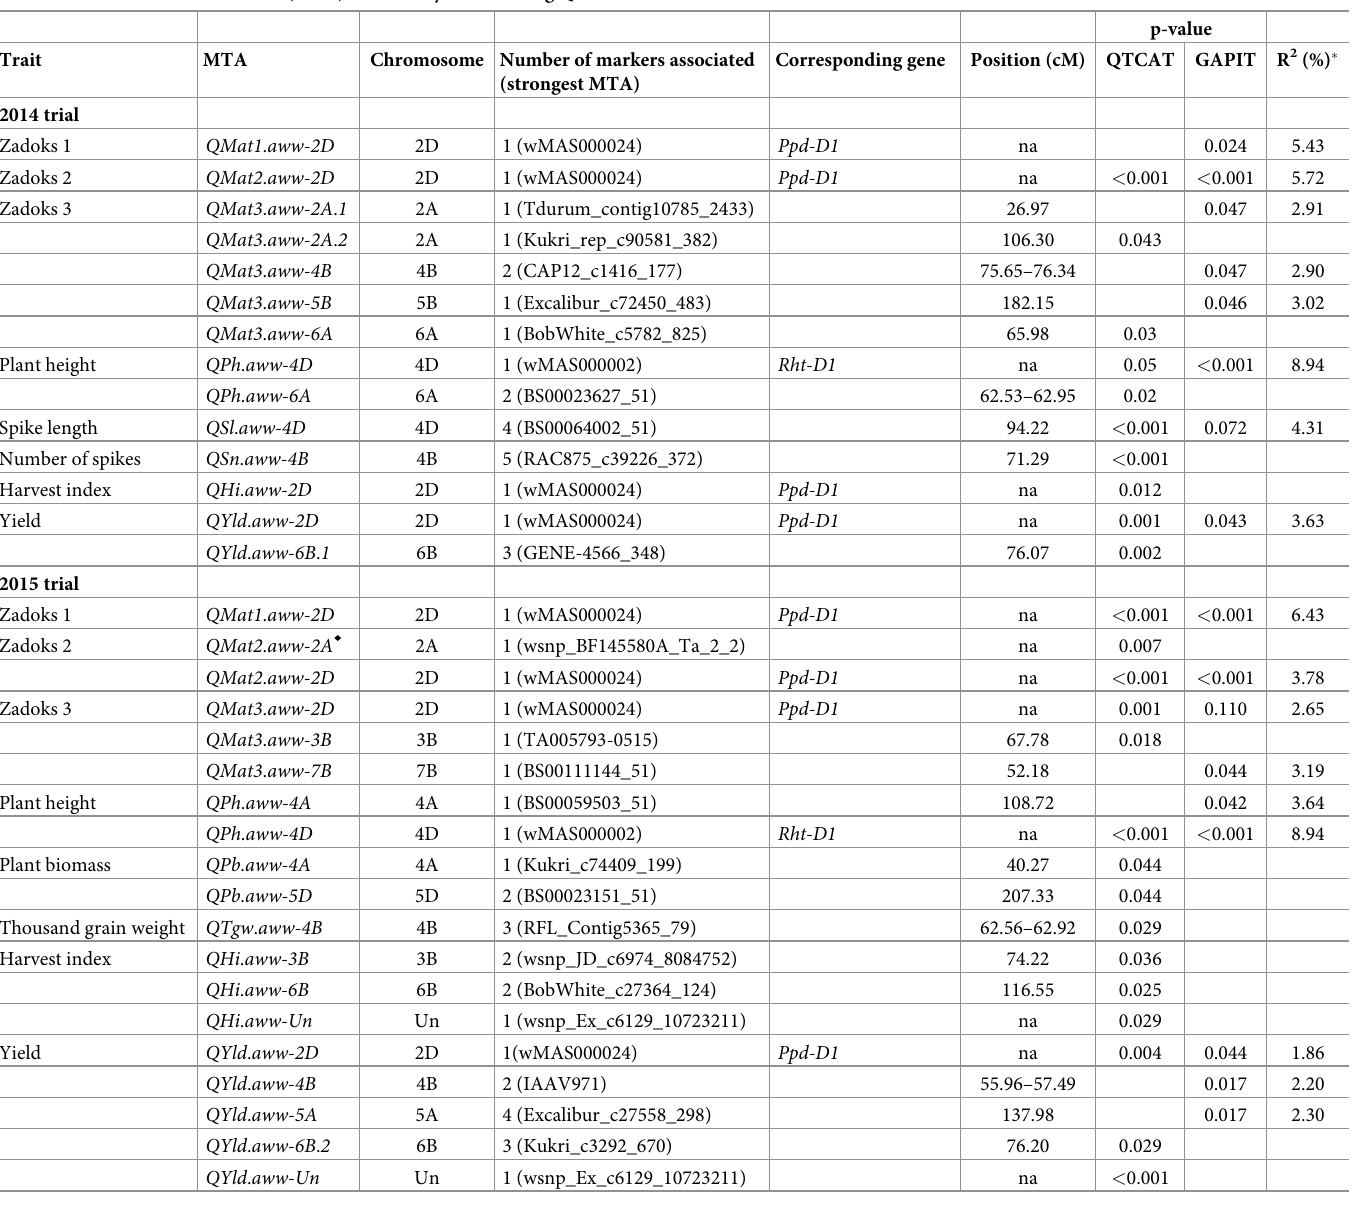
Table 2. Marker-trait associations (MTA) detected by GWAS using QTCAT and